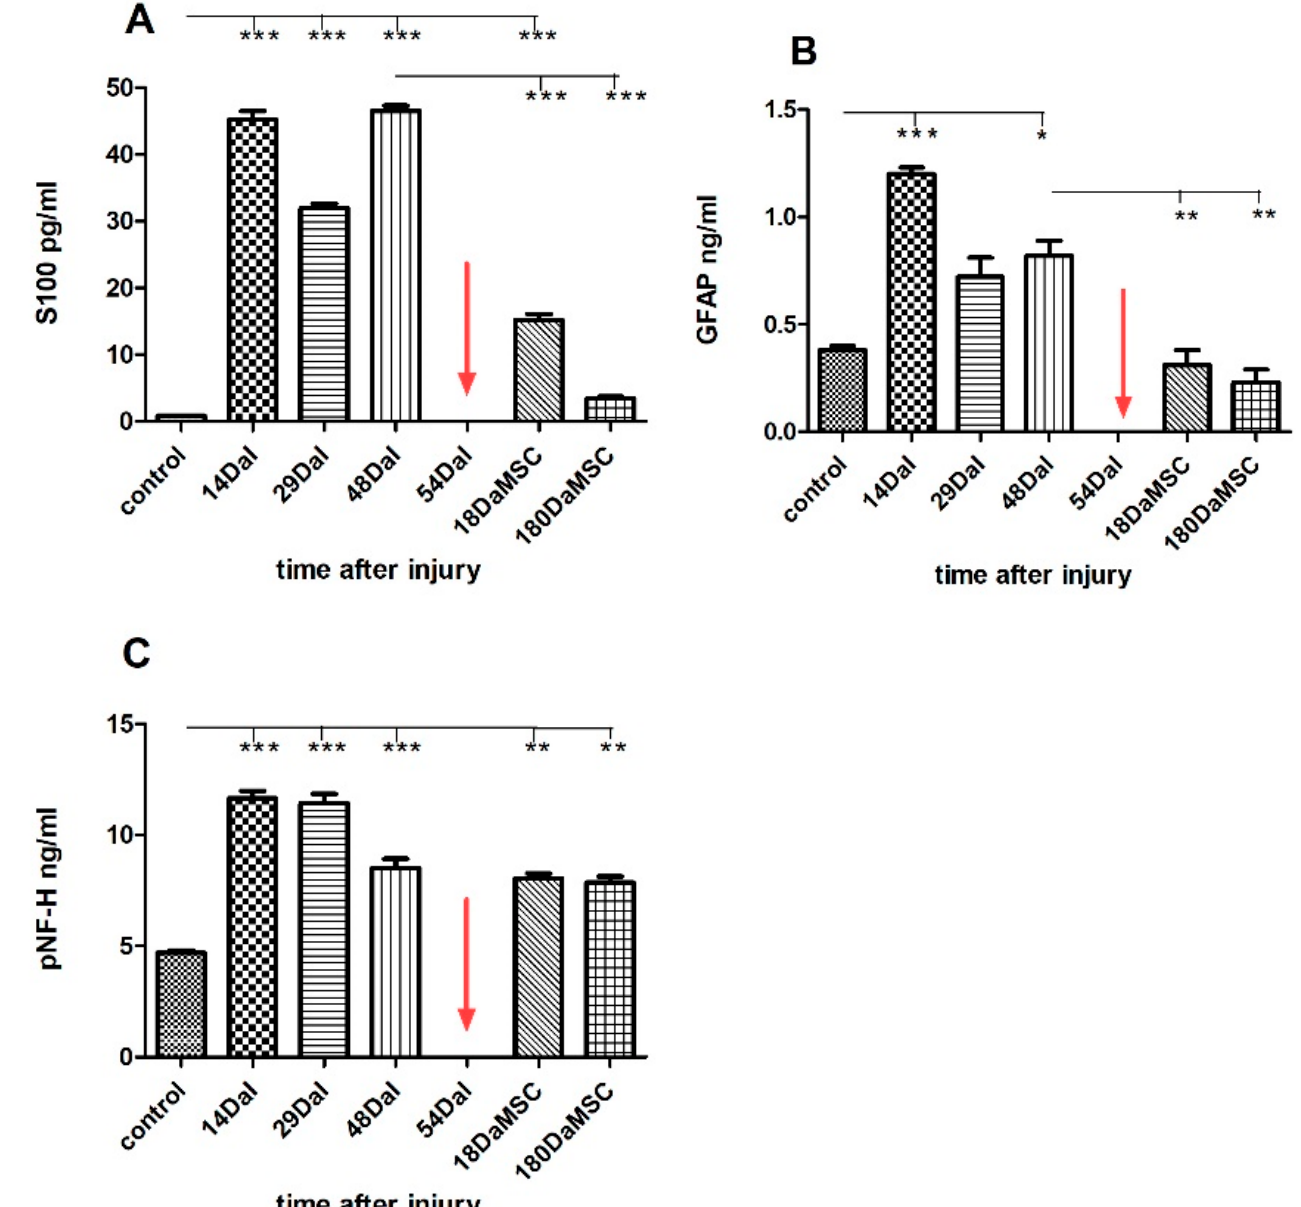
Figure 4. The levels of S100, GFAP, and pNF-H protein in the CSF of an SCI patient treated with autologous BM-MSCs. Protein values are obtained from CSF on the day of BM-MSCs application. The presence of glial cell proteins predominates over neuronal cell proteins. Data are shown as the mean ± SD, ** p < 0.01, *** p < 0.001. DaI—Days after Injury.